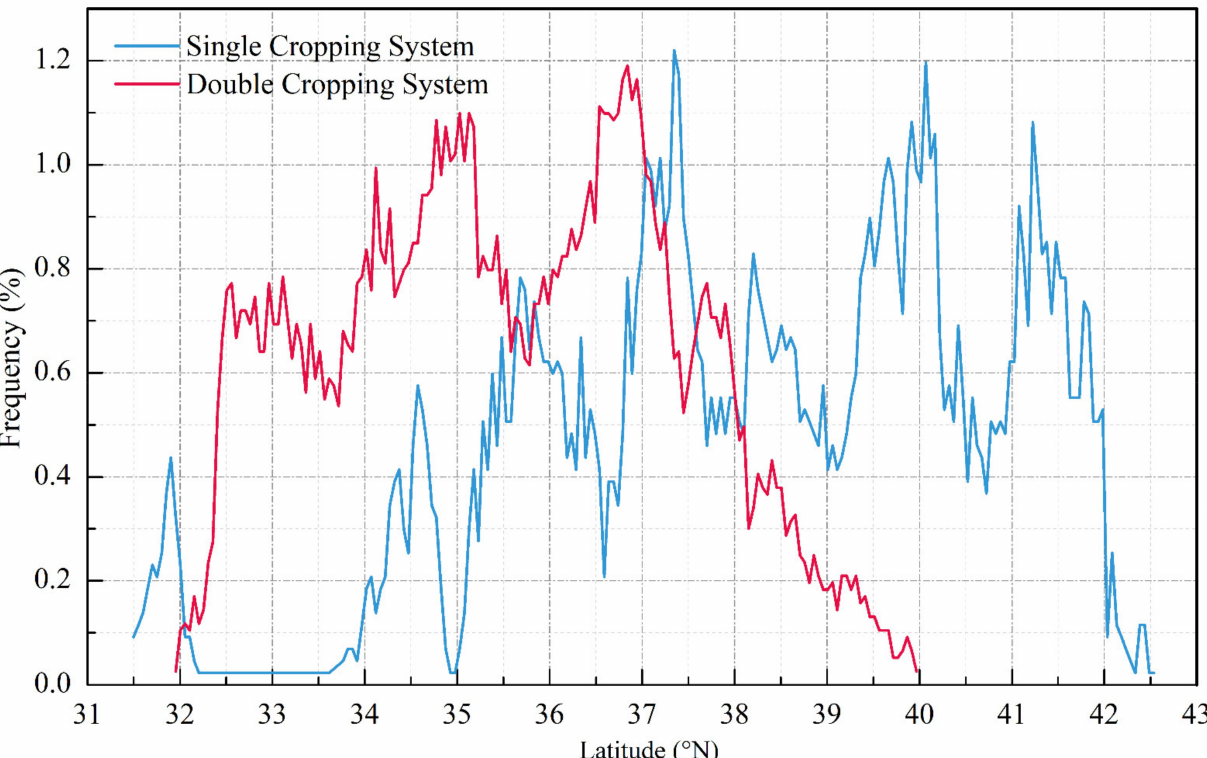
Figure 14. Frequency distribution of the SCS and DCS cropping systems at different latitudes on the NCP from 1982 to